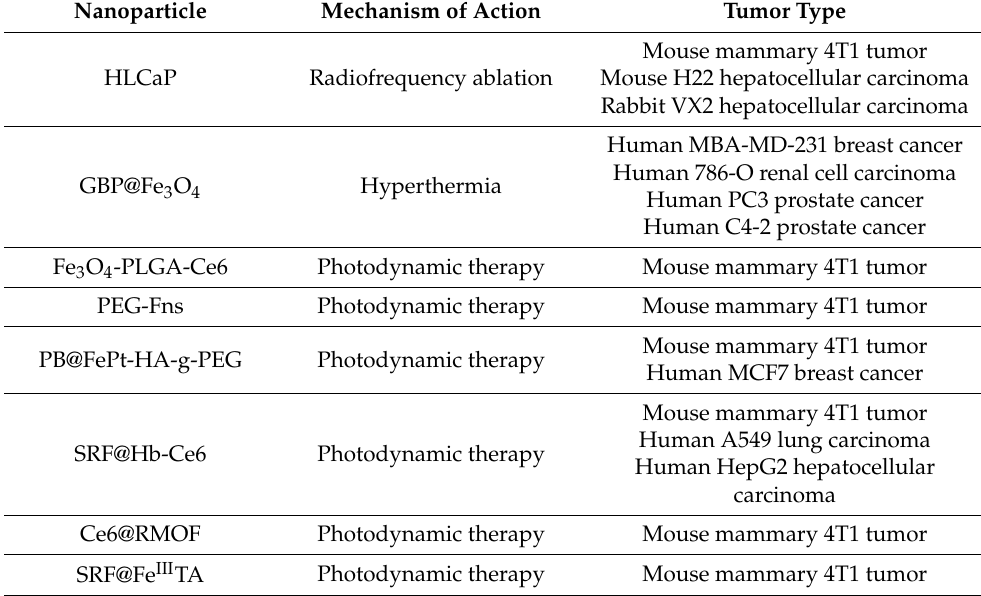
Table 4. Nanoparticles for radiofrequency ablation, hyperthermia, and photodynamic